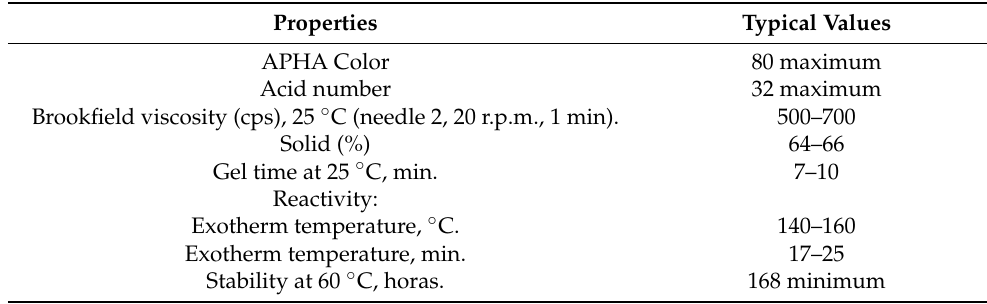
Table 1. The properties of Cristal á n 859. Properties Typical Values APHA